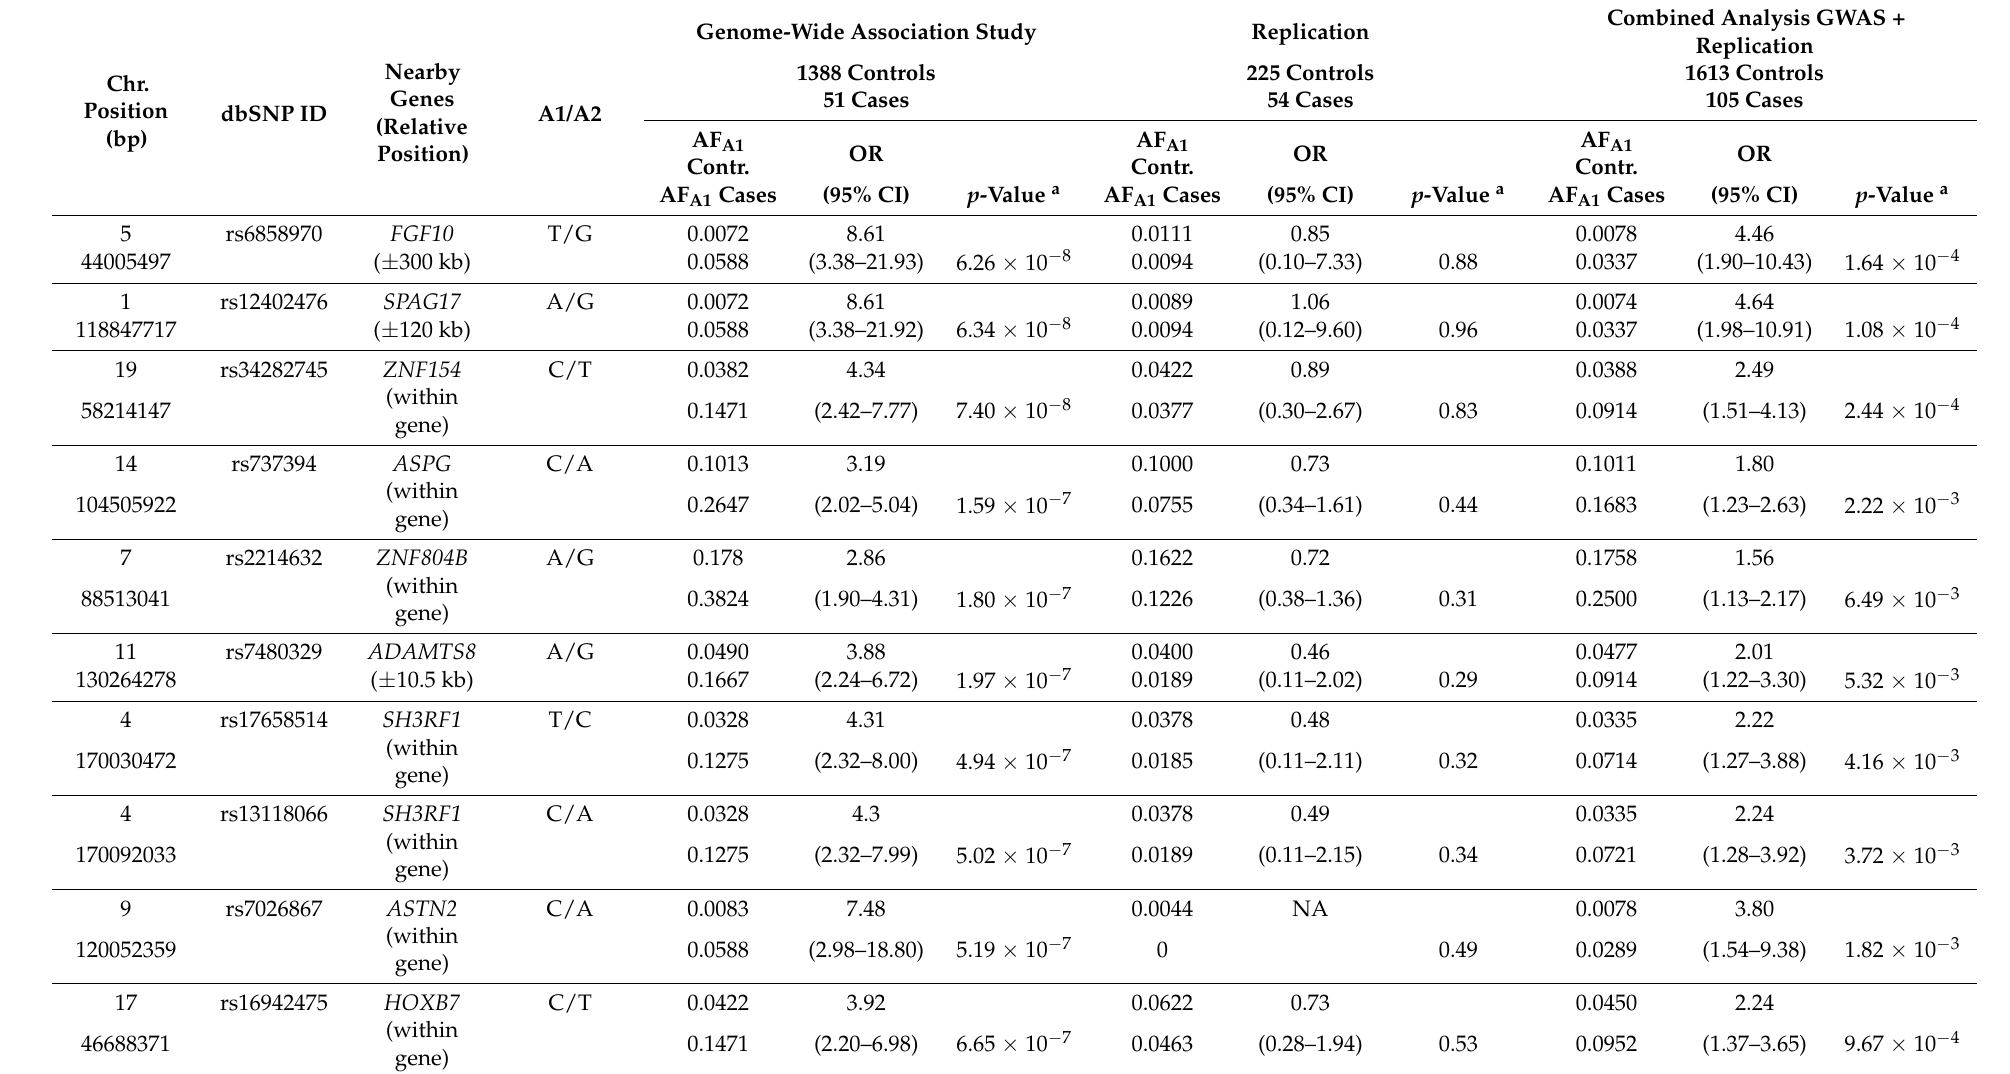
Table 3. Top SNVs associated with AP identified by genome-wide association analysis and replicated by Sanger sequencing: approach 2.